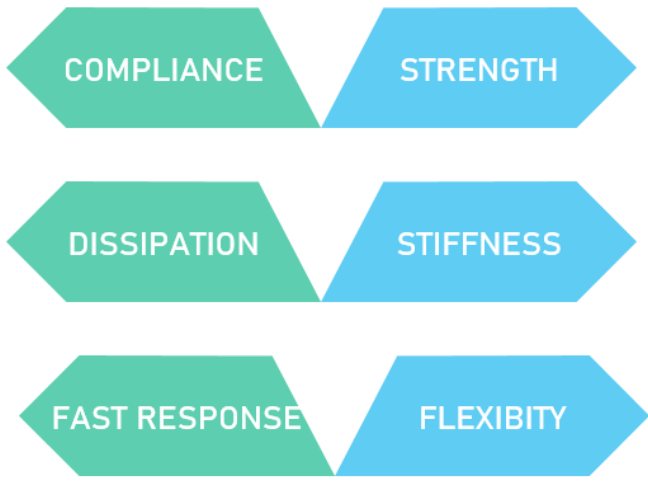
Figure 13. Performance Trade-offs in Bio-inspired structures [50].